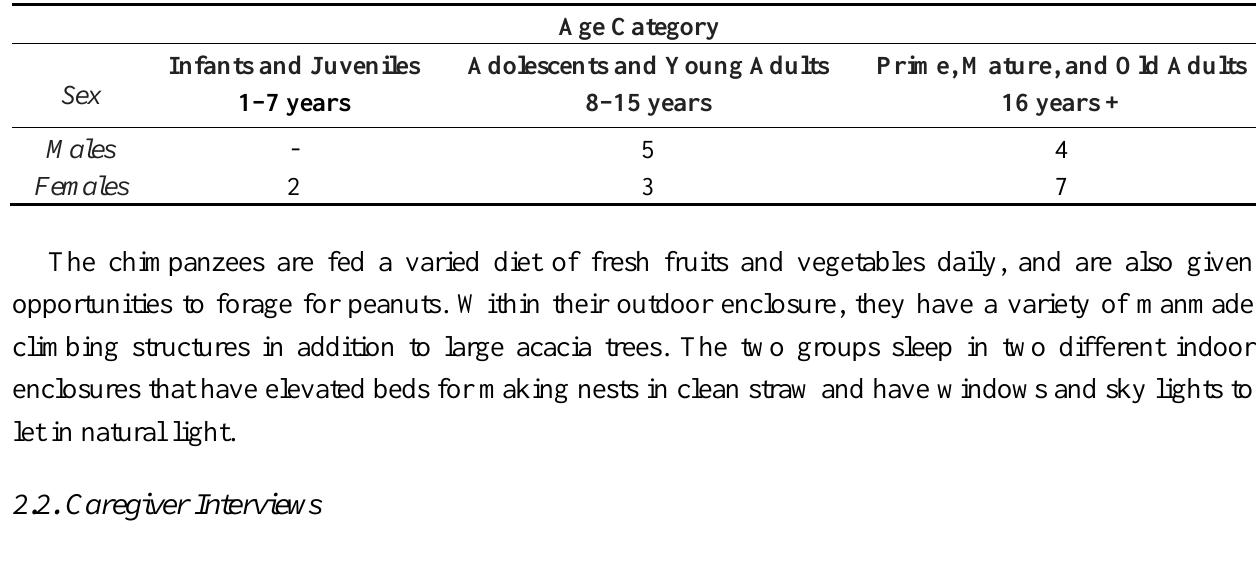
Table 1. Composition of Poco and Safari’s